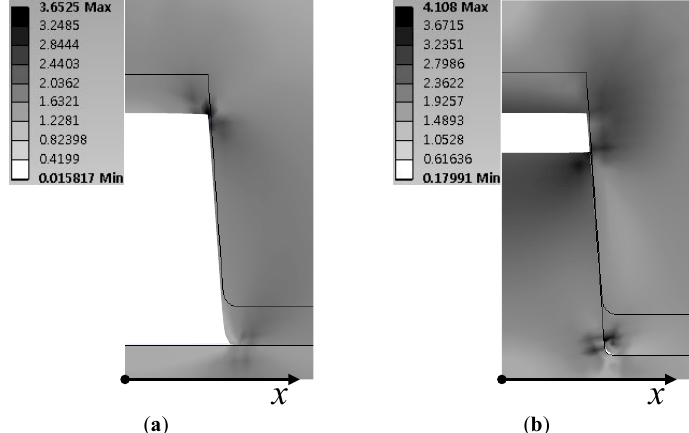
Figure 2. Simulation results of von Mises stress distribution around microchannel ( a ) without the interference fit and ( b ) with the interference fit. Applied pressure is 1 MPa. Interference height, width and draft angle are 500 µ m, 10 µ m and 4 ◦ ,